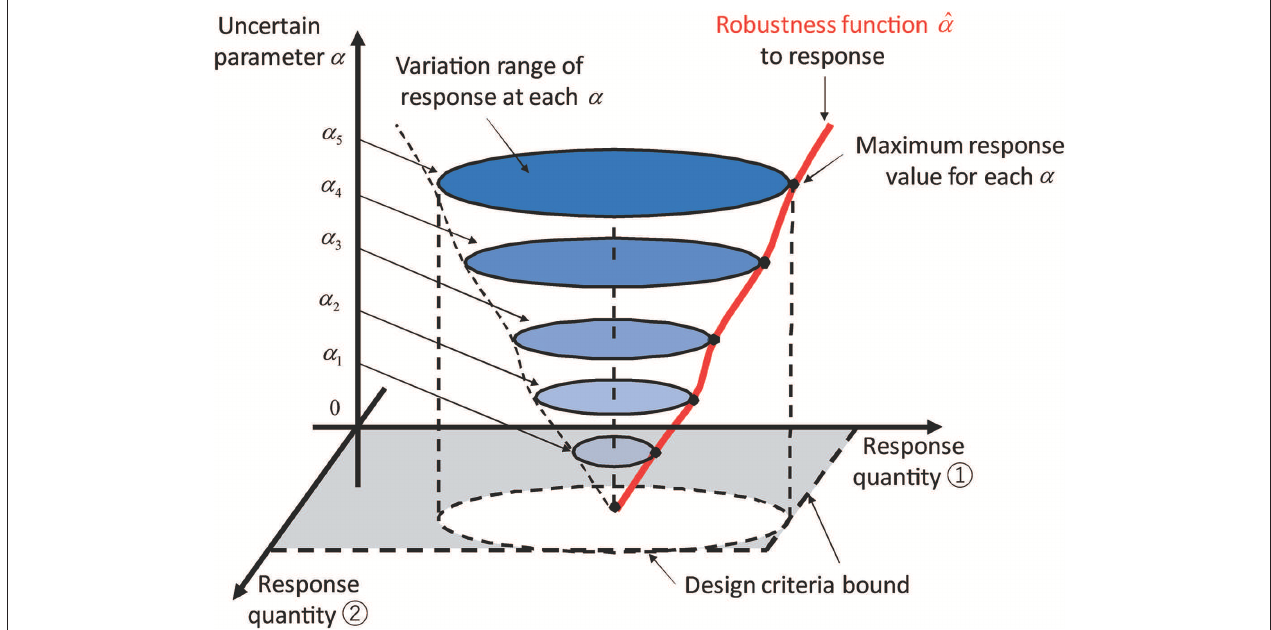
FIGURE 12 | Robustness function ˆ α for various uncertainty